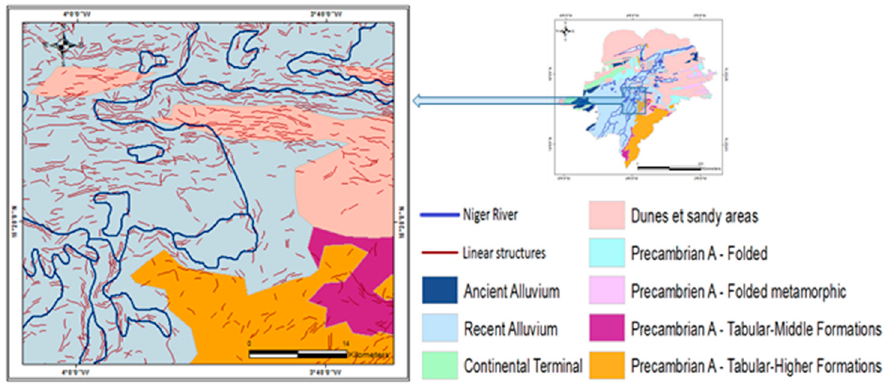
Figure 10. Litho-structural Map of Inner Delta of Niger.